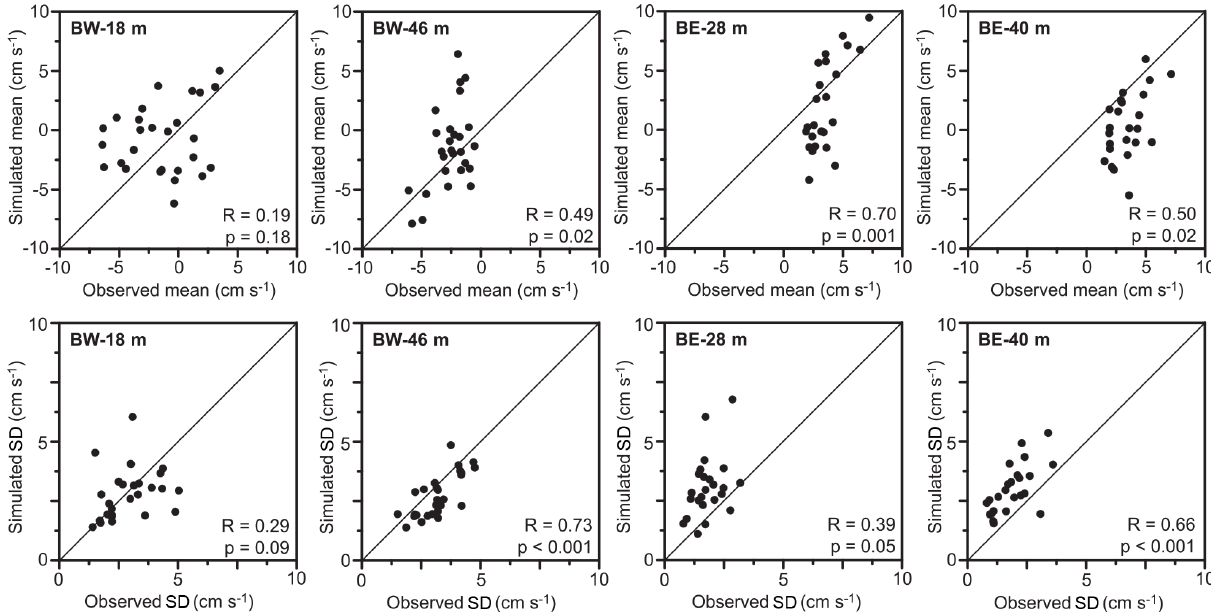
Figure 3. Comparison between observation and model for averages (top panels) and standard deviations (bottom panels) of along-strait velocity for consecutive 25h periods at two measurement depths for each of the ADCP sites (Fig. 2a) during the simulation period. Correlation coefficients ( R ) and their statistical significance ( p ) values are listed in the lower right corner of each plot. Diagonal lines indicate equality between model and observation. Here and elsewhere in the paper, the statistical significance of correlation coefficients has been corrected for serial correlation by the “modified Chelton” method recommended by Pyper and Peterman